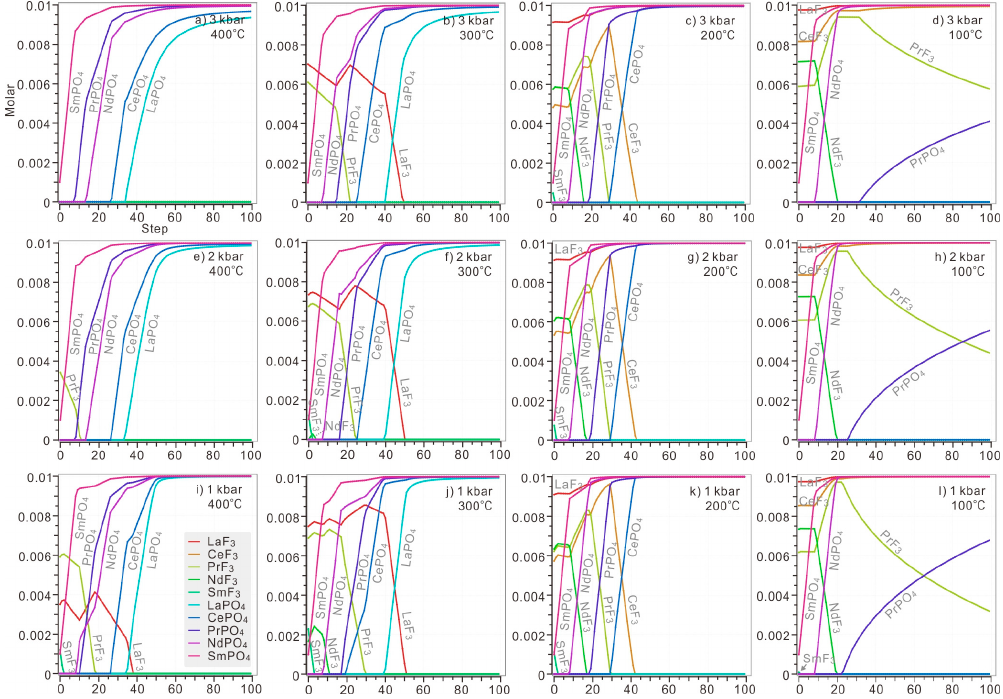
Figure 6. The precipitation of fluocerite and monazite in solution with 0.1 M HCl, 0.1 M HF, 0.1 M LaCl 3 , 0.1 M CeCl 3 , 0.1 M PrCl 3 , 0.1 M NdCl 3 , 0.1 M SmCl 3 and 0.001–0.1 M H 3 PO 4 . The H 3 PO 4